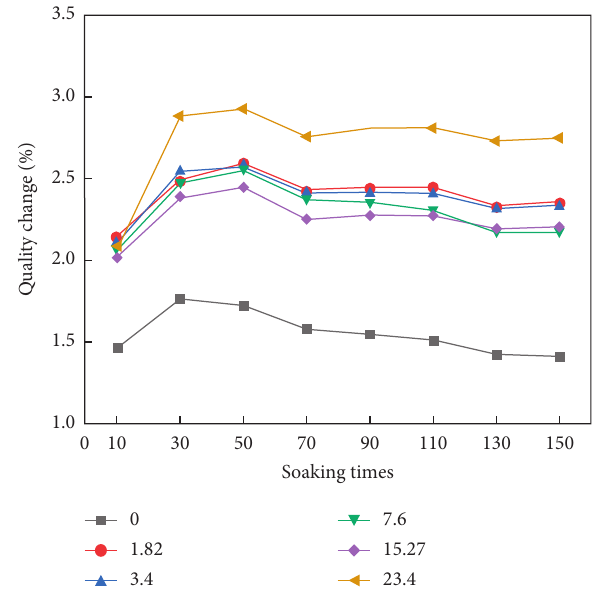
Figure 8: Quality